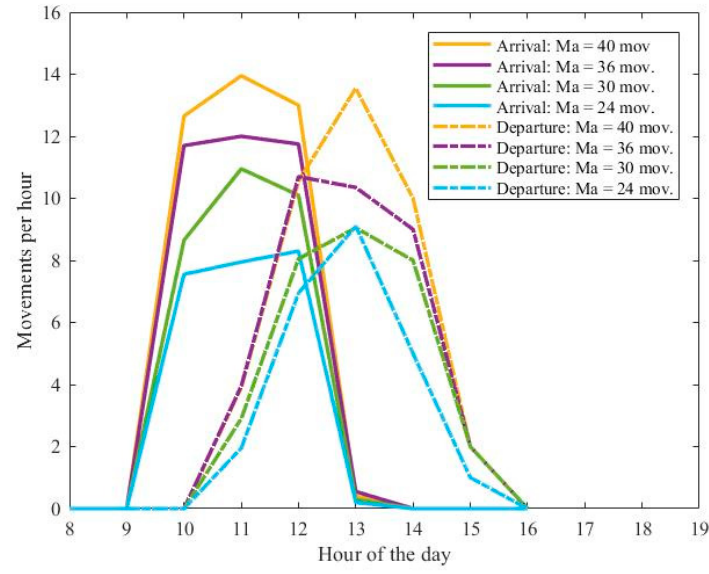
Figure 4. Simulated demand profiles.